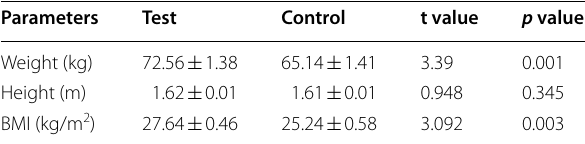
Table 1 Biophysical parameters of the prostate cancer patients and